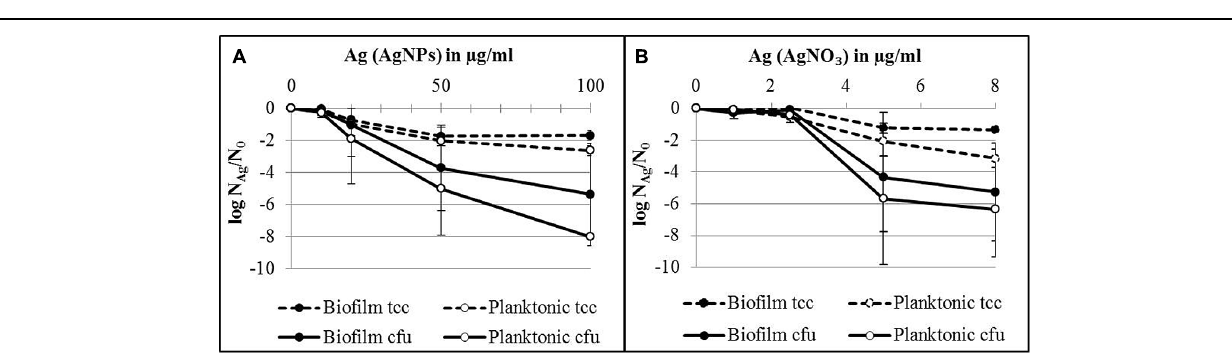
and biofilm cells from the bacterial cultures were separated after silver exposure and the culturability and the total cell counts were determined. The results are expressed as logarithmic quo- tient of N Ag (culturability or total cell counts of silver exposed